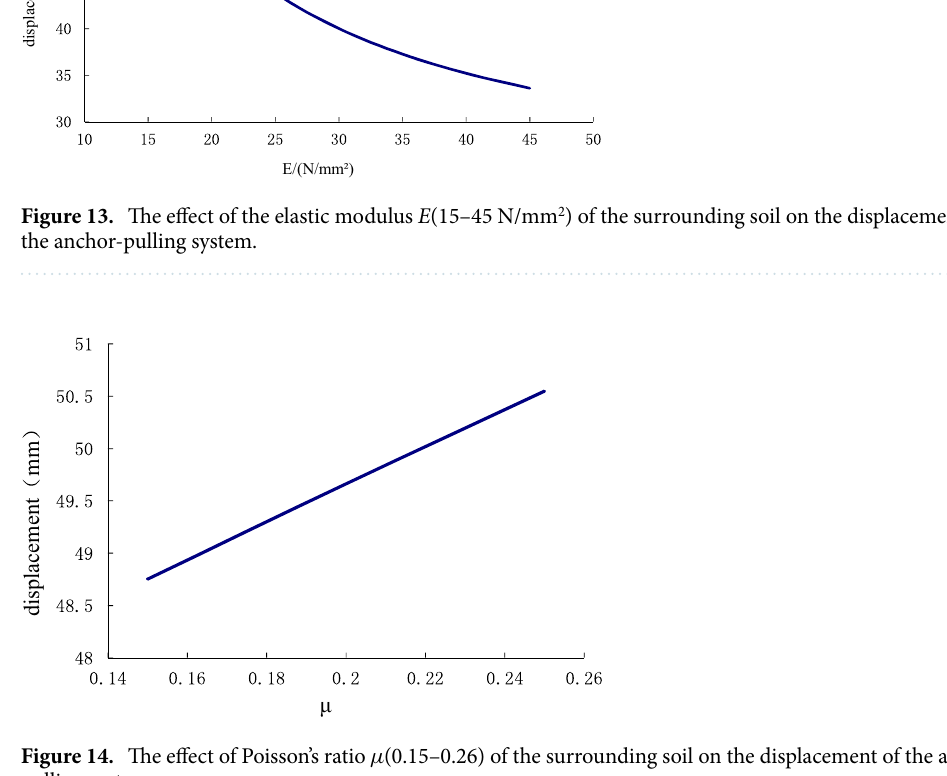
20 N/mm 2 . The parameter of gully bed soil is shown in Table 1. =